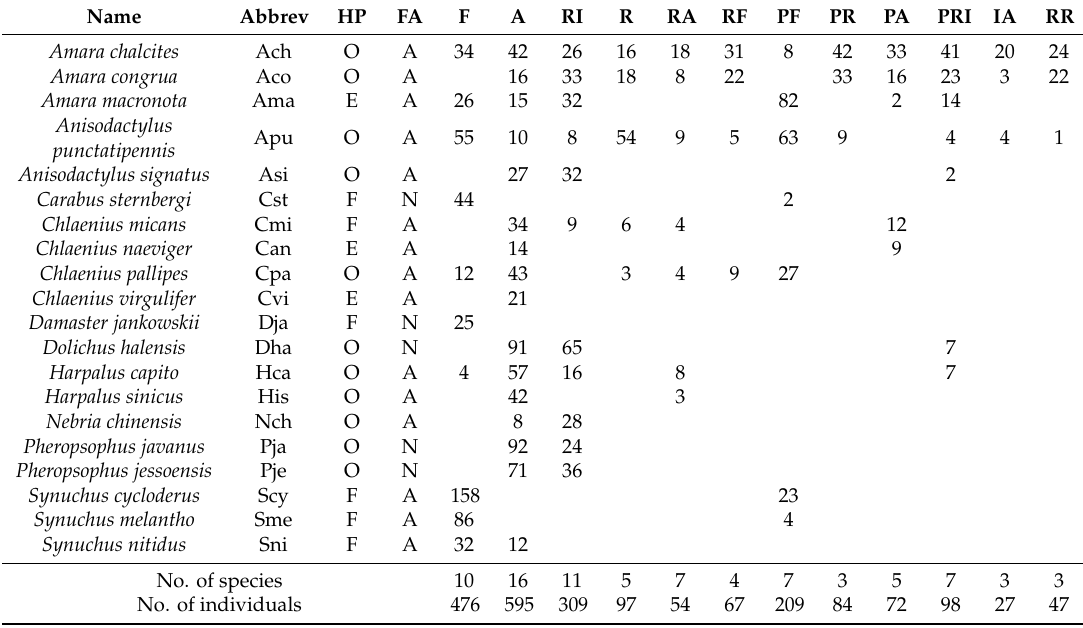
Table 1. Carabid beetles in di ff erent land-use types in the new town.